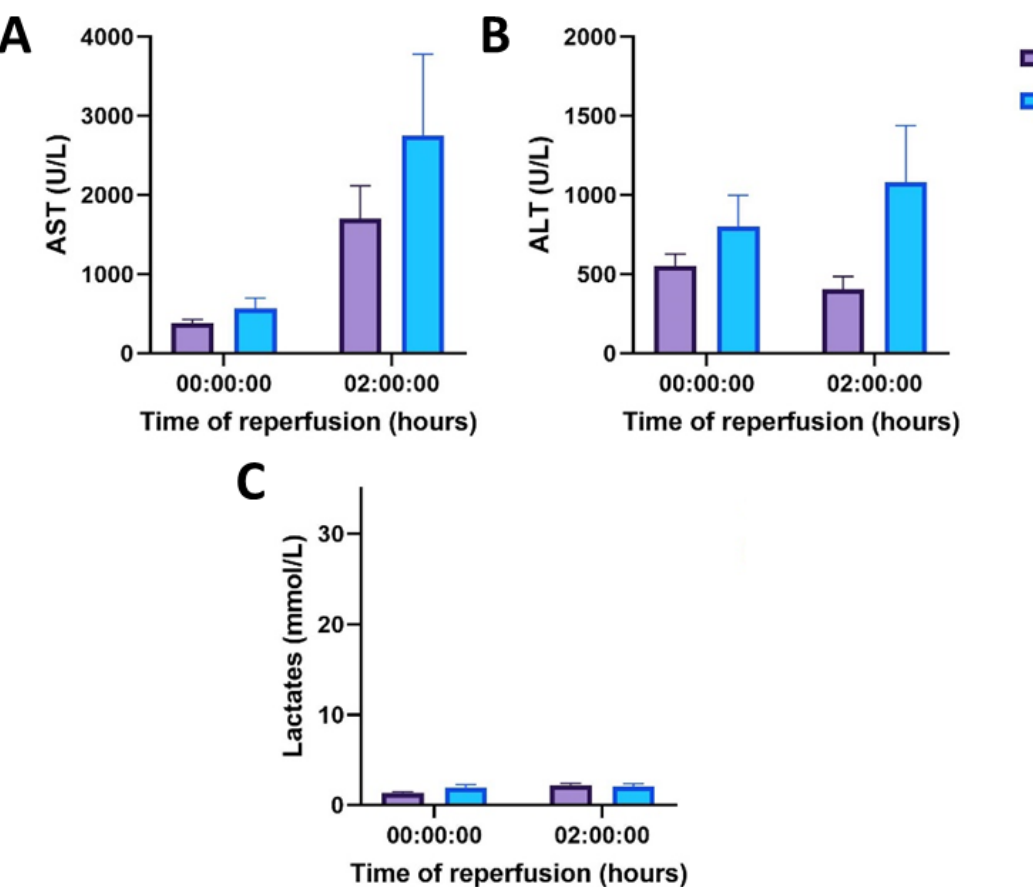
Figure 6. Hepatocellular injury markers quantification and anaerobic state evaluation. ( A ) Aspartate aminotransferase (AST) levels tended to be lower in the IGL2 group than in the PERFGEN group after 2 h of reperfusion ( p = 0.53). ( B ) Alanine aminotransferase (ALT) expression tended to be decreased in the IGL2 group compared to the PERFGEN group after 2 h of reperfusion ( p = 0.28). ( C ) No differences were observed in the lactate levels between the two groups. n = 6/group.